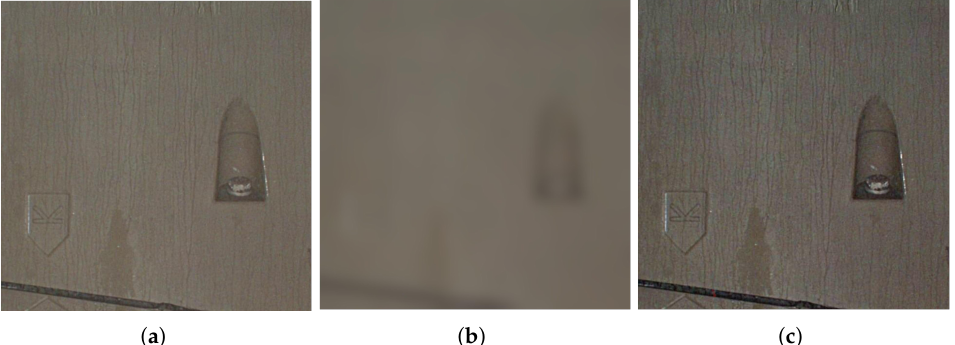
Figure 3. Original and illumination images. ( a ) Original image; ( b ) Illumination image estimated by Gaussian filter; ( c ) Illumination image estimated by